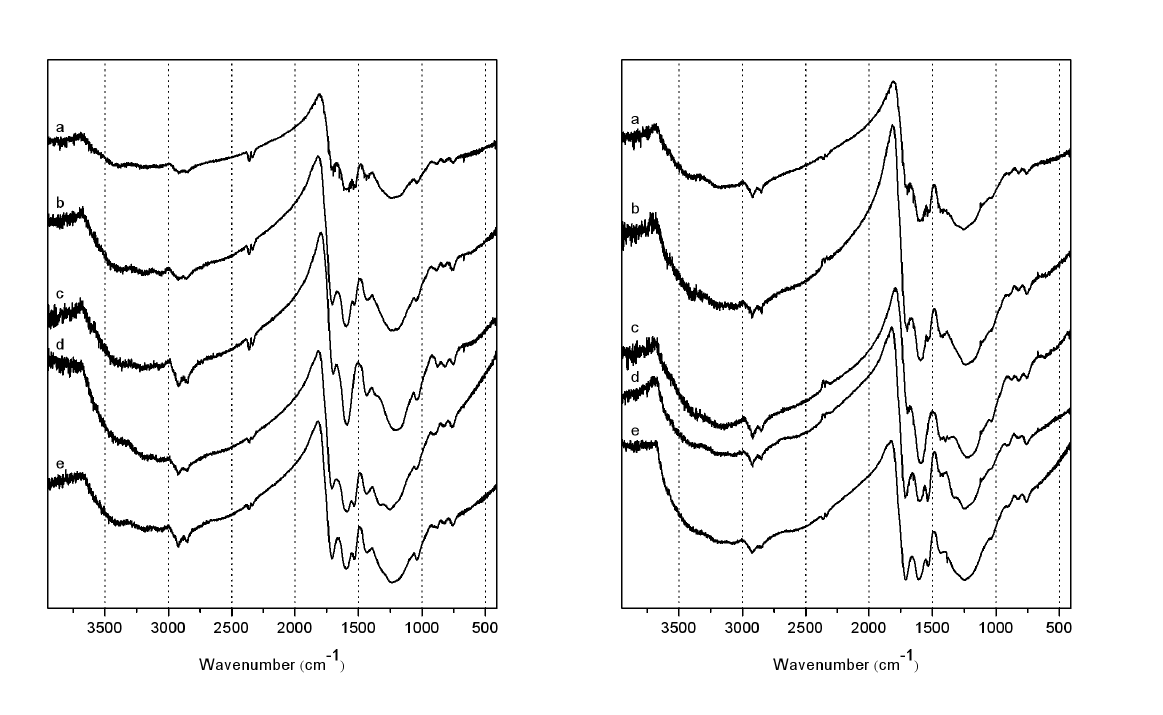
Fig. 3 FTIR spectra of solid products of extraction with THF: (a) dpf, (b) O 2 /125, (c) O 2 /Na 2 CO 3 , (d) 5% HNO 3 , (e) PAA.